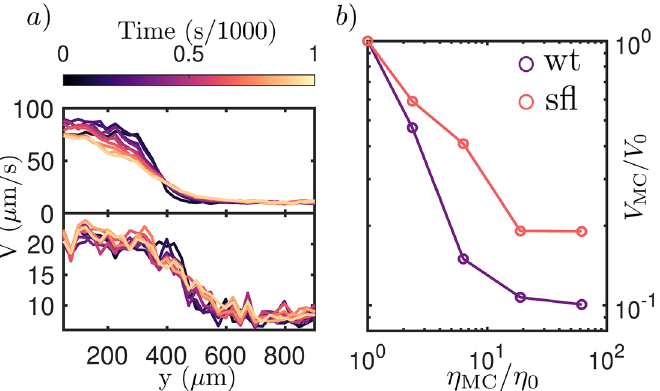
Figure 2. ( a ) Swimming velocity of wild-type (top) and short flagella (bottom) Chlamydomonas reinhardtii algae as a function of their position in the device in experiments in which 0.30% MC ( 6 η 0 ) is used for the high viscosity region between 0 and 1000s after the syringe pump is stopped at the beginning of the experiment (see Fig. 1 for a coordinate system reference), showing that the gradient is stable for the time of interest. ( b ) The velocity ratio V MC / V 0 as a function of the concentration of MC in the high viscosity region. Figure panels were arranged and labels were added using the proprietary software Affinity Designer 1.8 (https ://affin ity.serif .com/ en-gb/desig